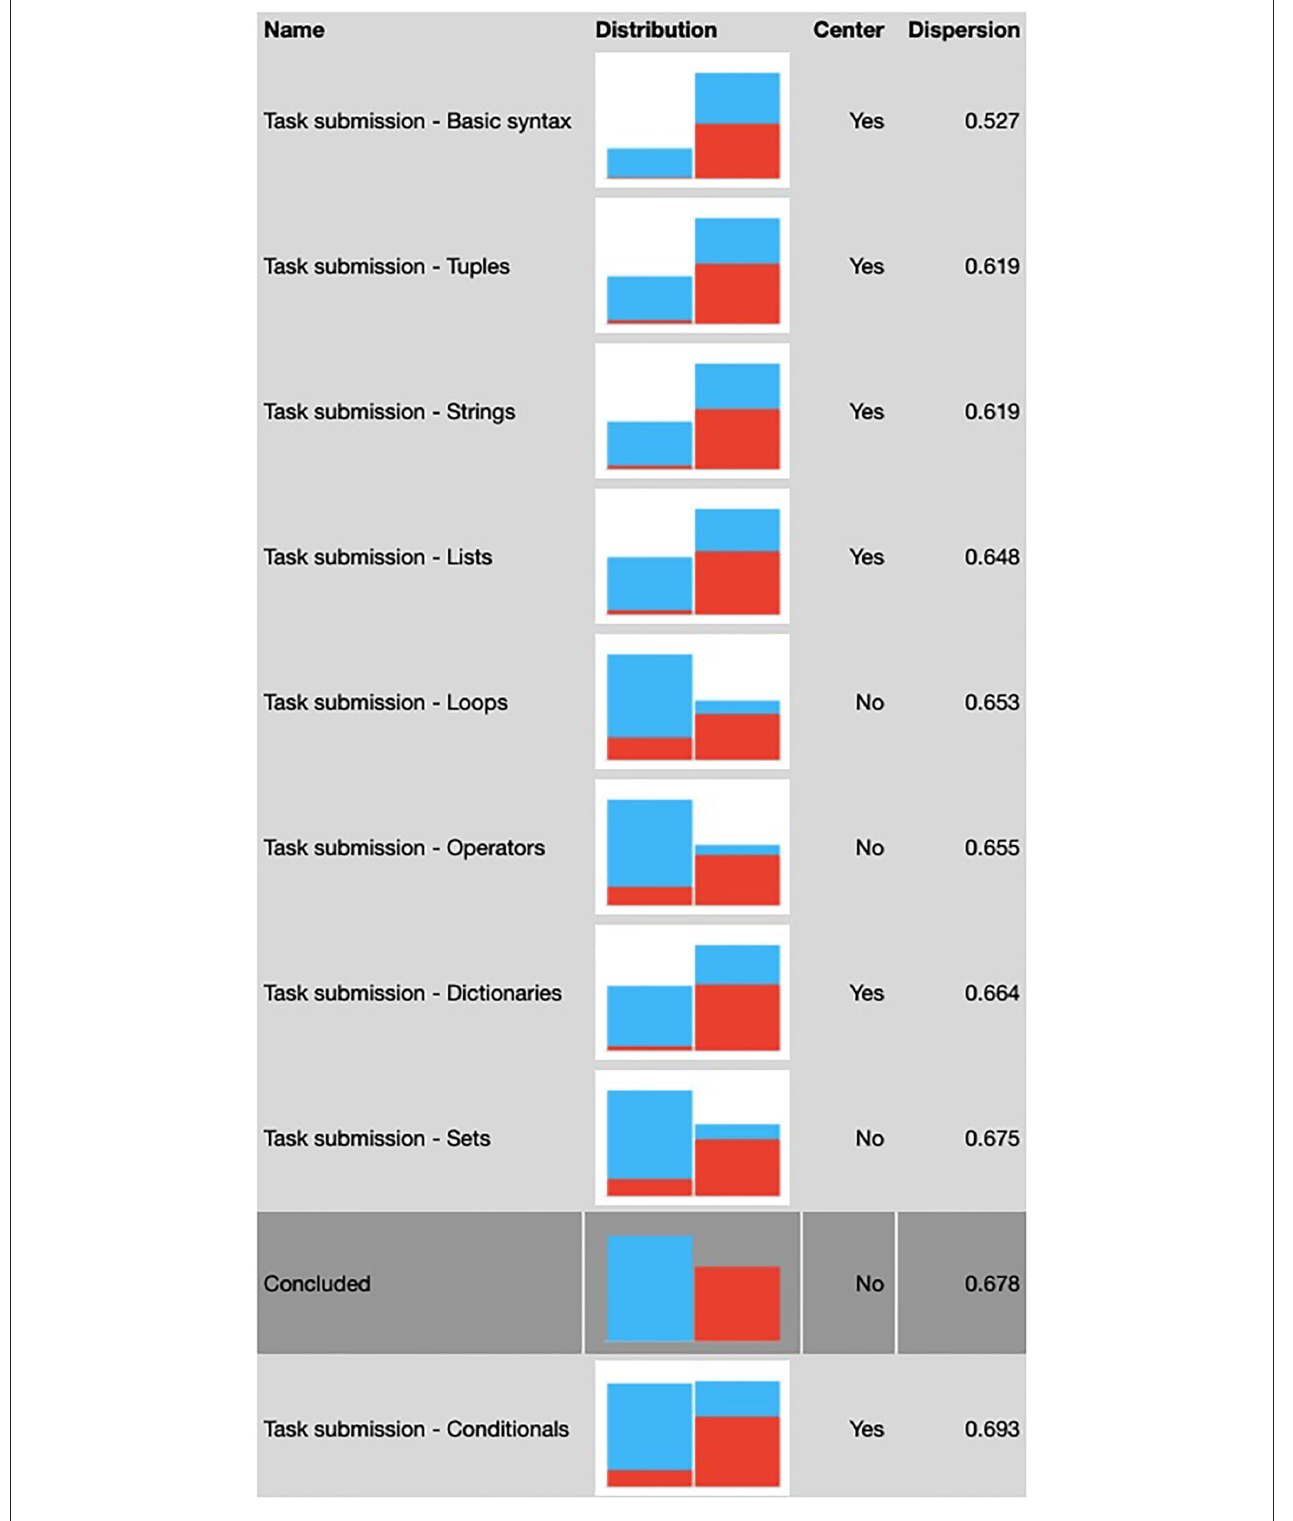
FIGURE 3 | Task submission statistics related to course completion. Each line is a specific task list. The line in a darker shade of gray shows the proportion of students who conclude the course (red) and dropped out (blue). The left bar is composed of students who did not hand the task and the right is composed of the ones who did